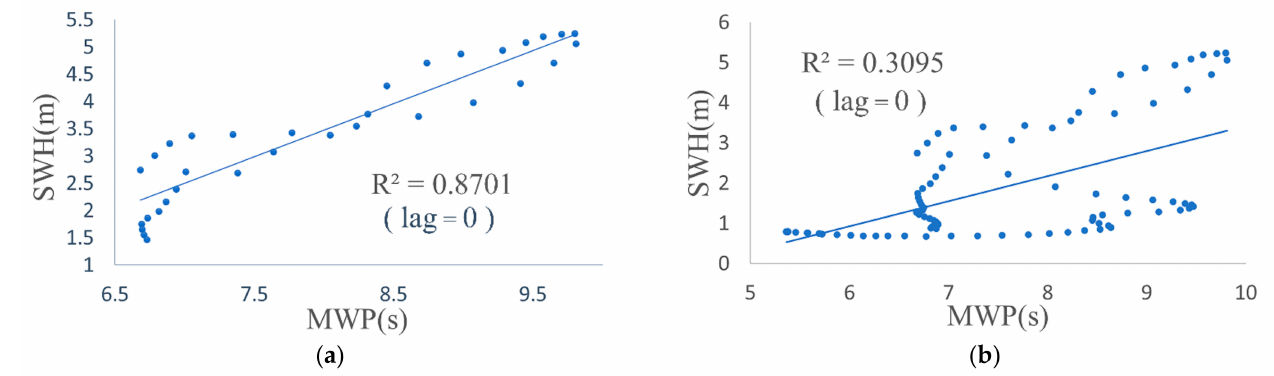
Figure 6. Correlation diagram between mean wave period (MWP) and significant wave height (SWH): ( a ) correlation diagram of wind wave time, from 23:00 on 30 September to 7:00 on 2 October; ( b ) correlation diagram of SWH and MWP from 5:00 on 29 September to 23:00 on 2